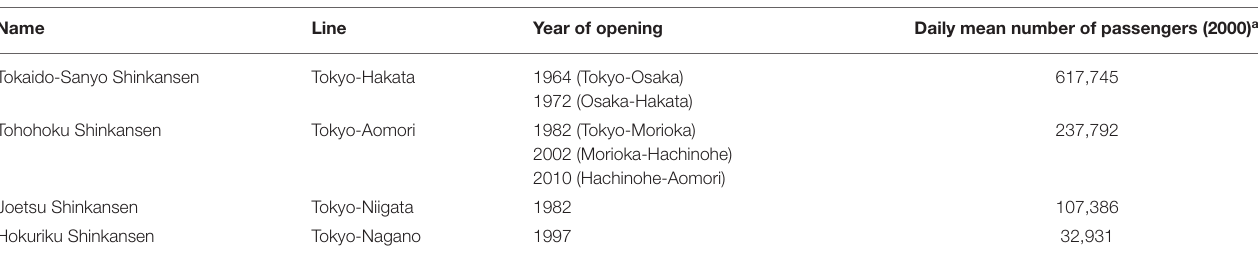
TABLE 1 | Summary of the high-speed rail